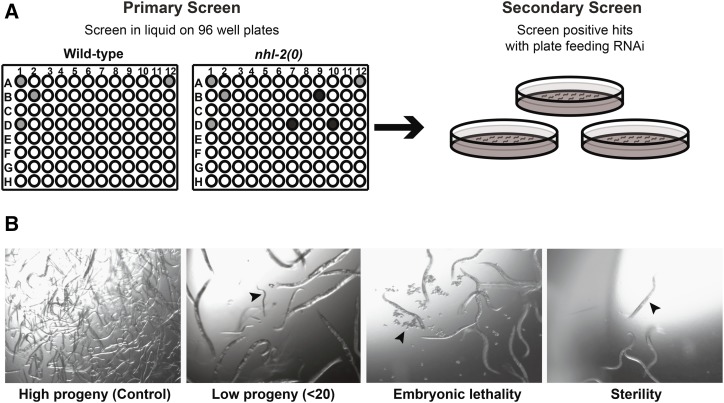
Genome-wide RNAi screening methodology. (A) Outline of primary liquid RNAi screen. Approximately 10 L1 wild-type or nhl-2(0) worms were deposited into each well of a 96-well plate that contained bacteria expressing dsRNA clones. Black wells represent phenotypes that are present in wild-type animals with no enhancement in nhl-2(0) mutants. Gray wells represent positive hits, where enhanced phenotypes were observed in nhl-2(0) mutants. Positive hits were then validated by plate feeding RNAi (secondary screen). (B) Representative DIC images of phenotypes as observed during the scoring process (arrows).